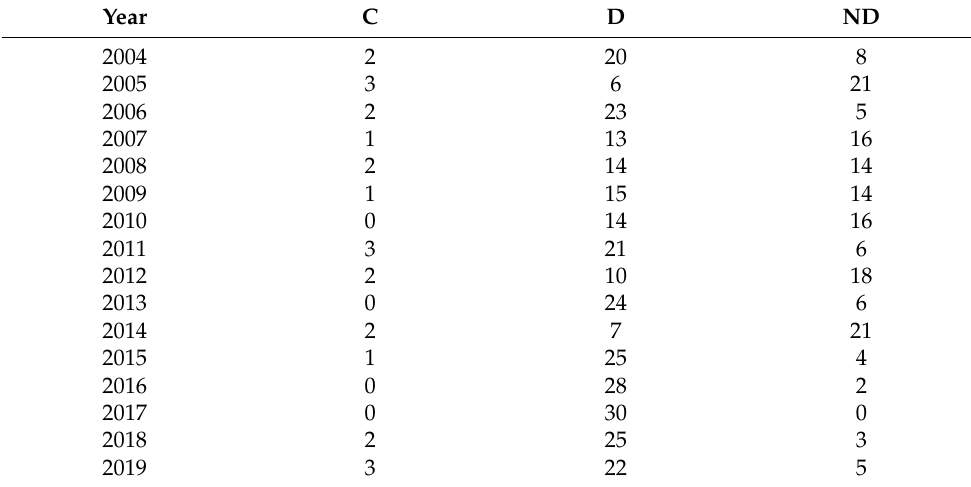
Table 5. Evolution of the number of provinces in three decoupling